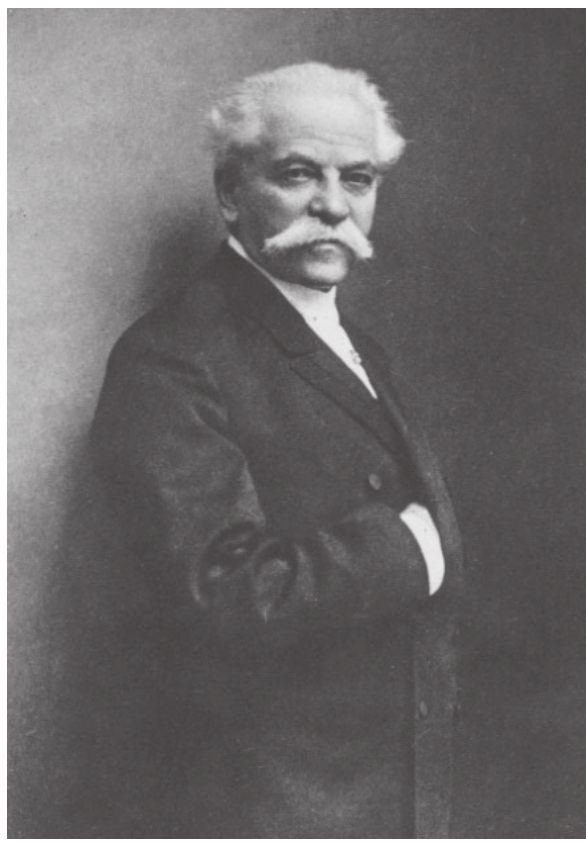
Figure 4. Heinrich Caro (1834-1910) (Edgar Fahs Smith Memorial Collection. Kislak Center for Special Collections, Rare Books and Manuscripts. University of